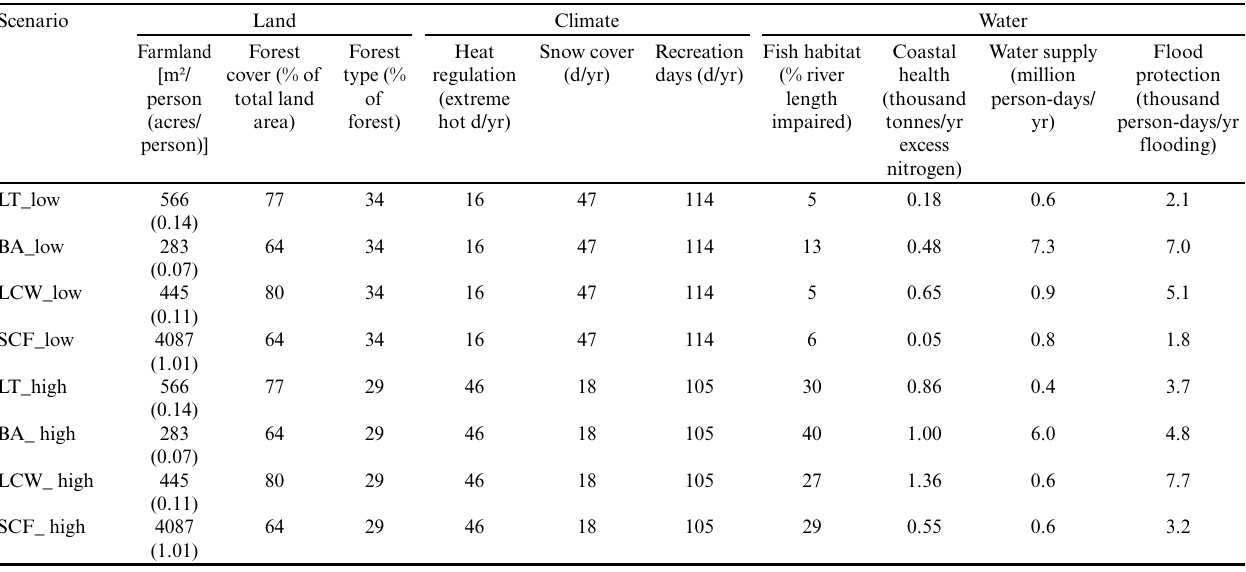
Table 3. Predicted levels of environmental indicators in the upper Merrimack River watershed for each land-cover and climate scenario in 2070–2099 (Samal et al. 2017). Scenarios: low = low emissions, high = high emissions, acronyms defined in Table 2.